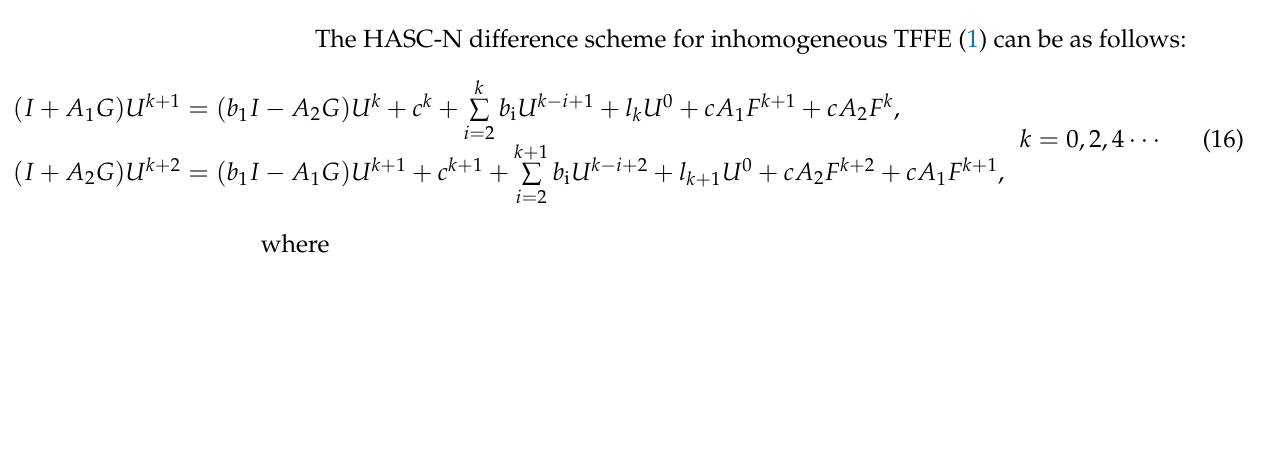
Figure 1. Construction principle of HASC-N difference